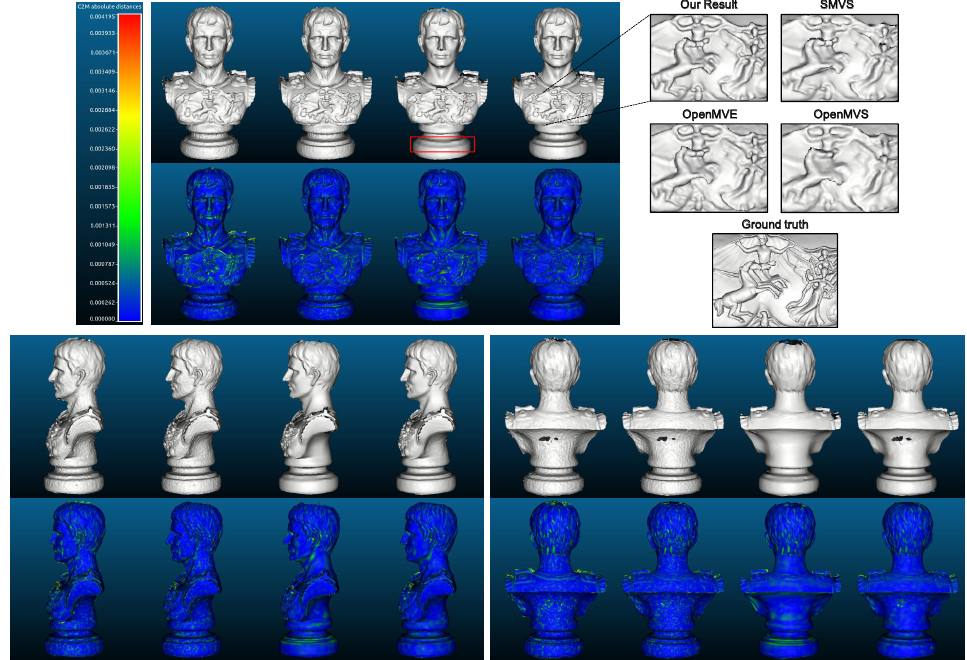
Figure 15. Snapshots of reconstructed models and deviation maps (meter) to the reference model from the front, side and back views. For each view, from left to right are the results of MVS, MVE, SMVS and our approach respectively. For fair comparison, the FSSR algorithm [41] integrated in MVE environment is exploited to extract the surface from dense point clouds, for all evaluated